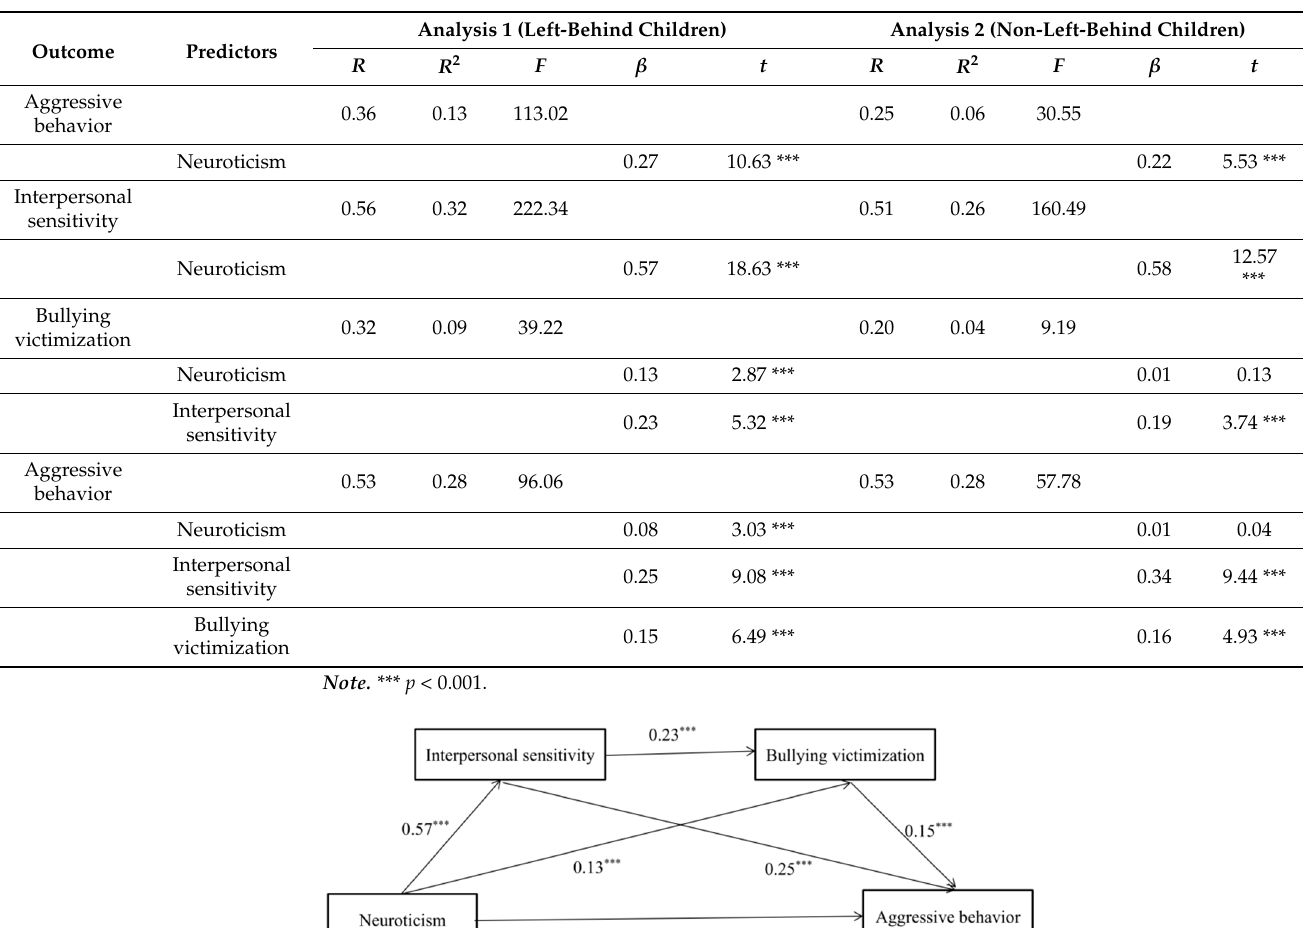
Table 2. Results of mediation analyses among left-behind children and non-left-behind children.